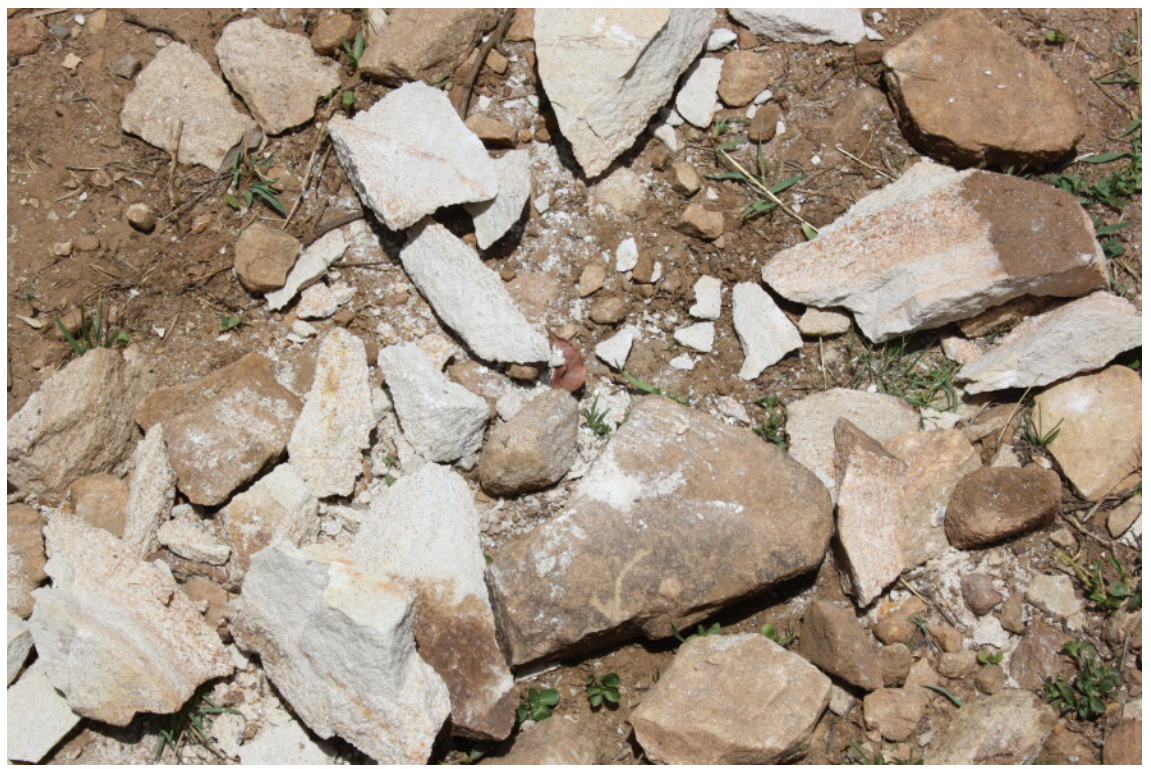
Figure 12. The debitage scattered at manufacturing